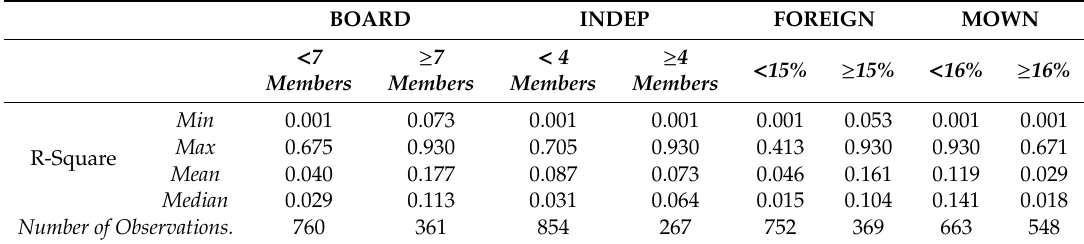
Table 4. Descriptive statistics of R-square according to di ff erent subgroups.